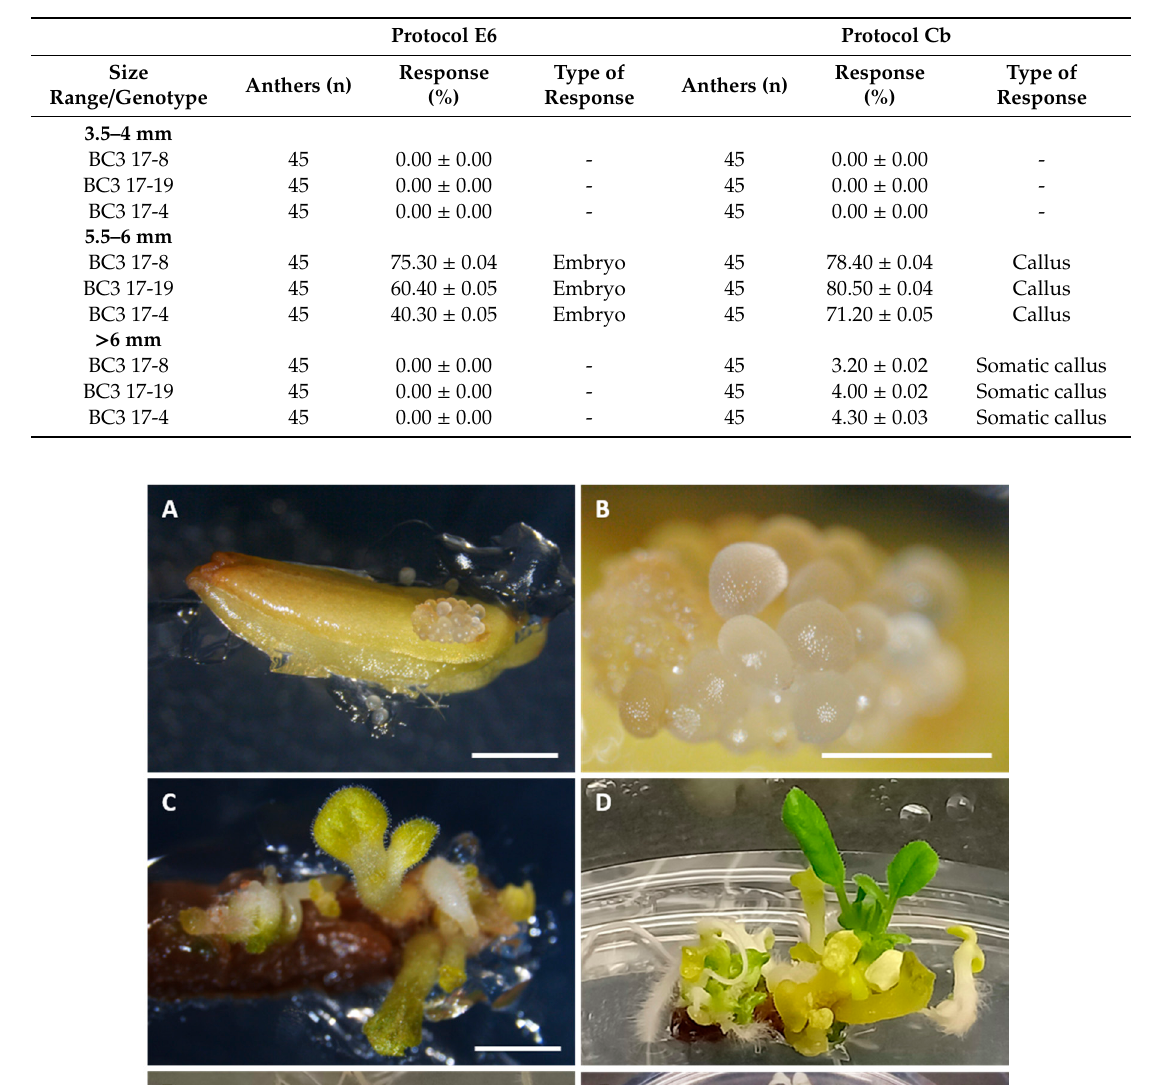
Table 3. Percentage and type of response in the three eggplant genotypes tested for the two protocols (E6 and Cb) and the three anther ranges selected. The response percentage ( ± SE) is presented. The type of response has been di ff erentiated depending on whether it was an embryogenic or a callogenic response.